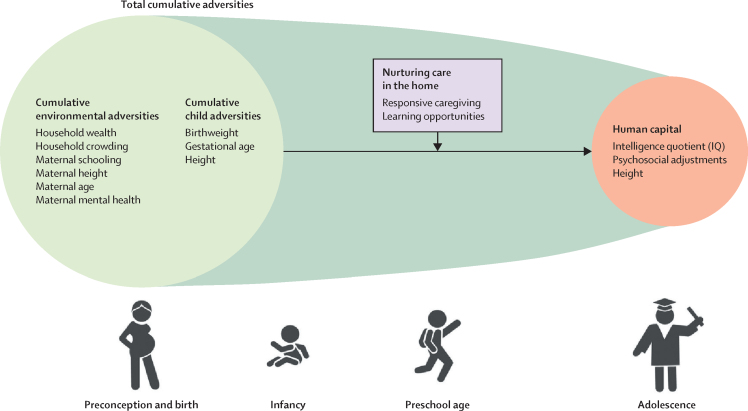
Conceptual model of the proposed association between early cumulative adversities and aspects of human capital in adolescence that might be modified by nurturing care in the homeNurturing care in the home and adolescent human capital are embedded within cumulative adversities throughout the life course.